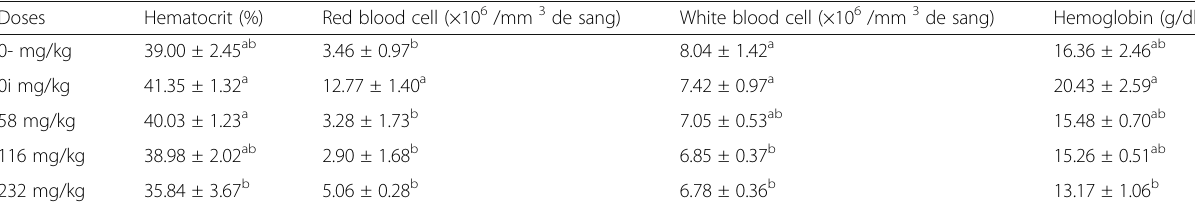
Table 9 Effects of doses of water macerated leaves extract of A . cordifolia on hematocrit, red blood cells, white blood cells and hemoglobin values after 2 weeks of administration to